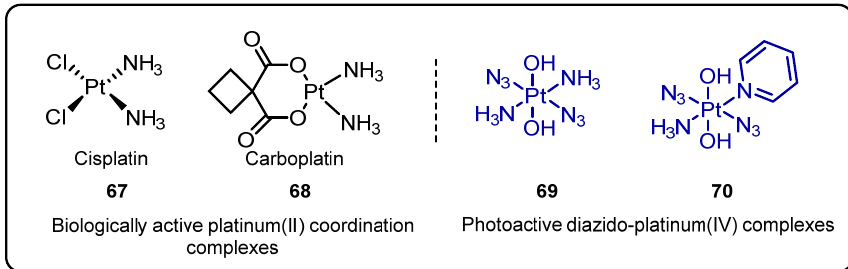
Figure 7. Some of the platinum complexes developed as anticancer